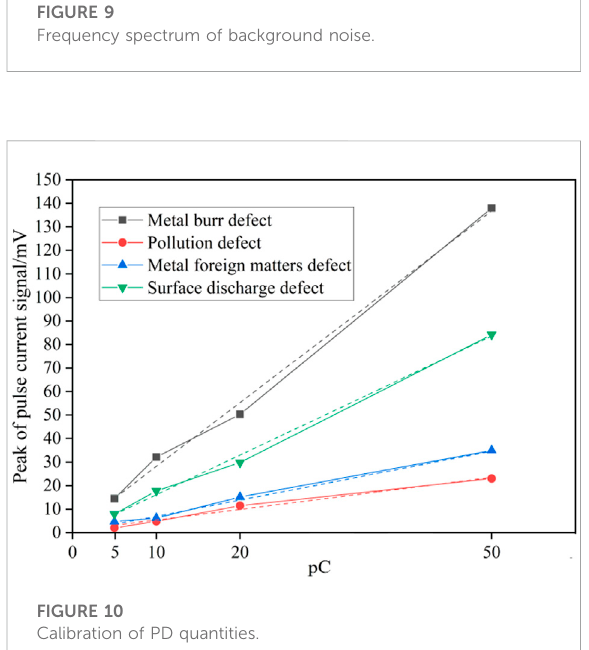
FIGURE 10 Calibration of PD quantities.